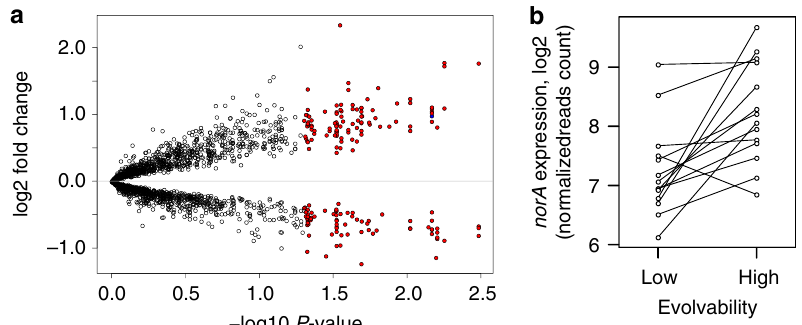
Fig. 3 Gene expression analysis. a Plotted points show the average difference (high evolvability − low evolvability) in gene expression between 14 pairs of high and low evolvability strains. Gene expression was measured after 1.5 h of exposure to cipro fl oxacin (1 mg l − 1 ) and each point represents a gene in the MRSA252 transcriptome (the number of genes is n = 2047). Signi fi cantly differentially expressed genes are coloured red ( p < 0.05, two-sided Wald tests) and norA is coloured blue. P -values were adjusted using Benjamini-Hochberg method. b The expression of norA in low and high evolvability strains. The read counts for the norA gene were normalised by sequencing depth. Pairs of strains are connected with a line (the number of pairs was N = 14). Two-sided Wald test: log 2 fold-change = 0.979, standard error = 0.246, t = 3.979, adjusted p = 0.006802703).